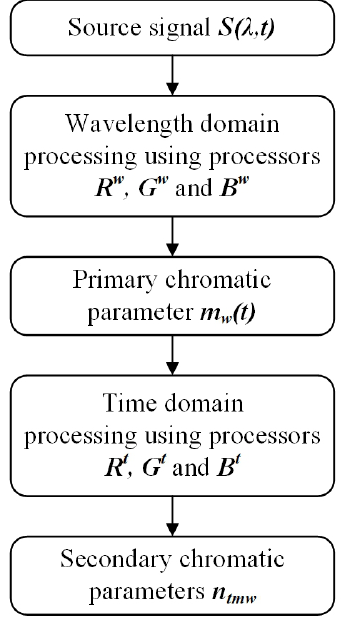
Figure 13. Flow chart for spectral data processing using chromatic methods ( m , n are x , y , z